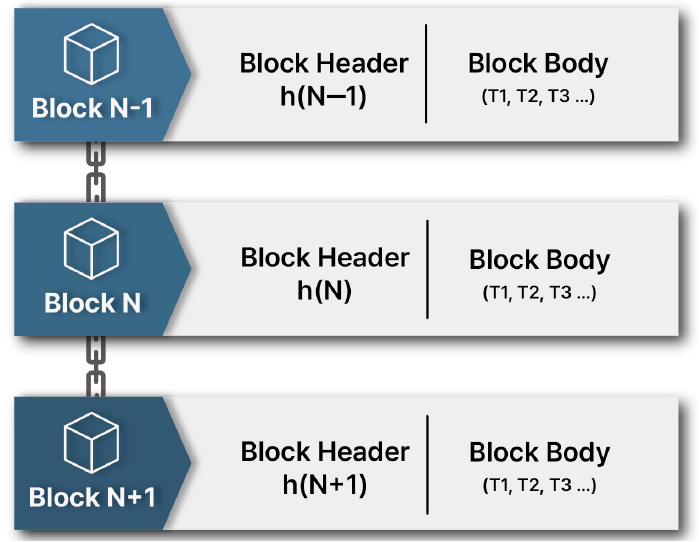
Figure 1. Structure of a blockchain.